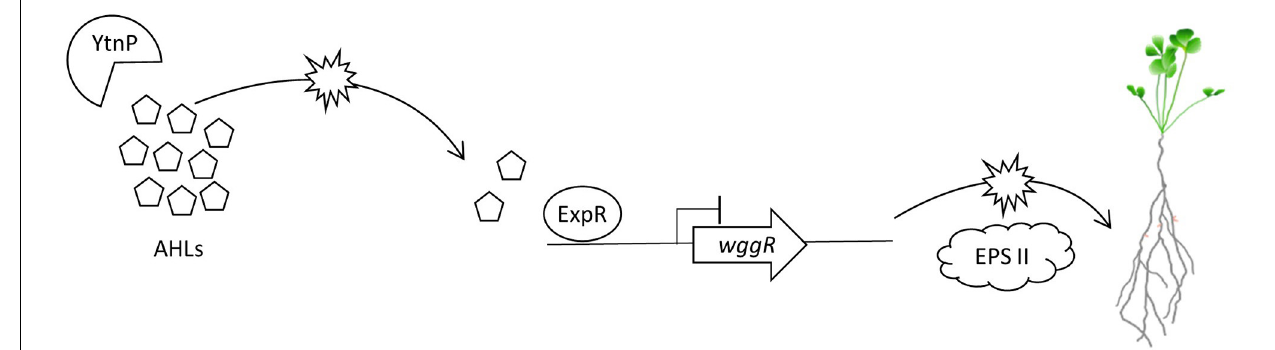
FIGURE 7 | Model of proposed molecular QS and QQ interactions between M. truncatula PGPRs. B. subtilis UD1022 produces the lactonase YtnP which cleaves S. meliloti Rm8530 AHLs. Through quorum quenching, UD1022 YtnP reduces AHL concentrations, inhibiting the upregulation of symbiotically active EPS II genes. This may result in lower nodulation efficiency of Rm8530 in the presence of the PGPR